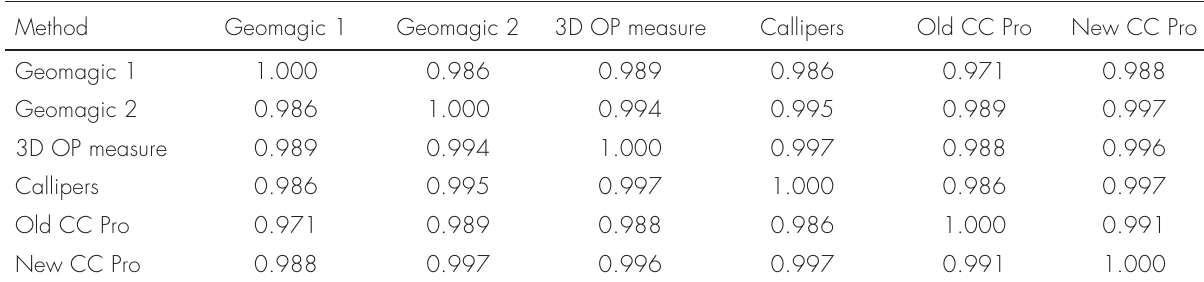
Table I. Reliability correlation matrix ( n = 40) for comparison of Geomagic with other